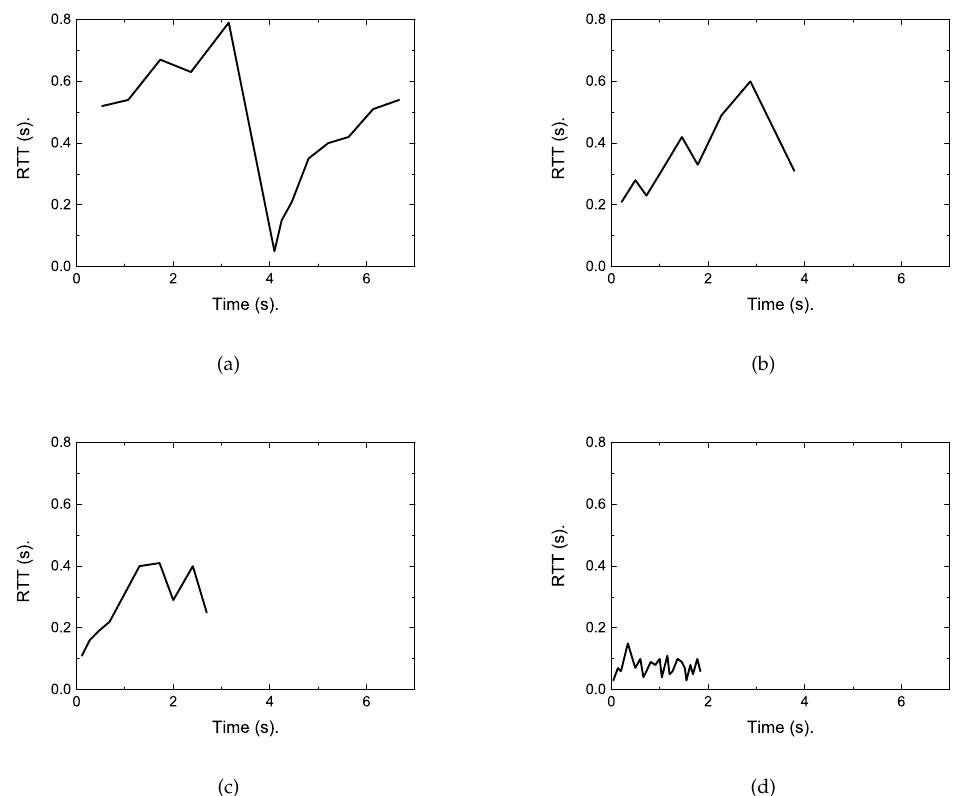
Figure 8. The traced RTT varying with time of each algorithm when a 128 kB short flow competes with a long flow with the size of 10 Mb. ( a ) TCP, ( b ) RTAC, ( c ) DRWA, ( d ) DFCSD.